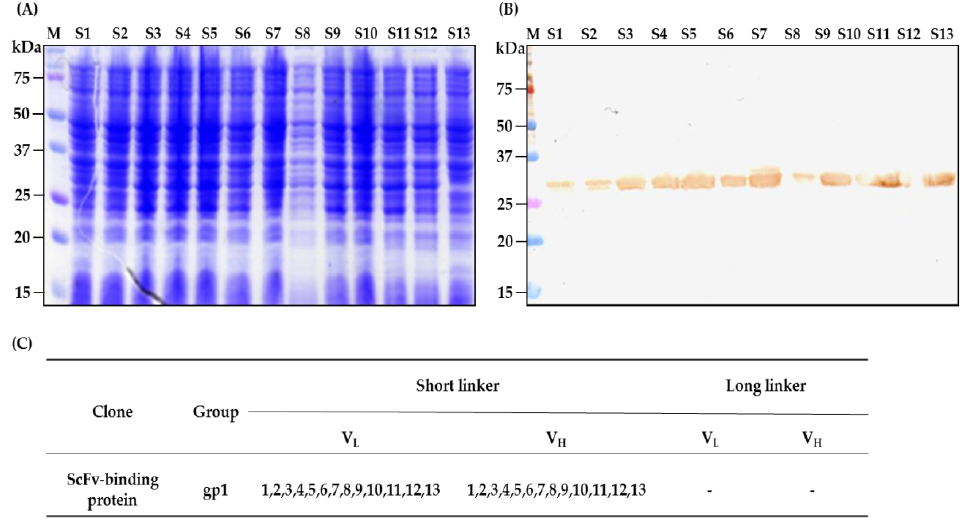
Table 2. Amino acid mutation rates of the light- and heavy-chain genes of the scFv antibody. ScFv Clone Region ScFv-binding protein S1